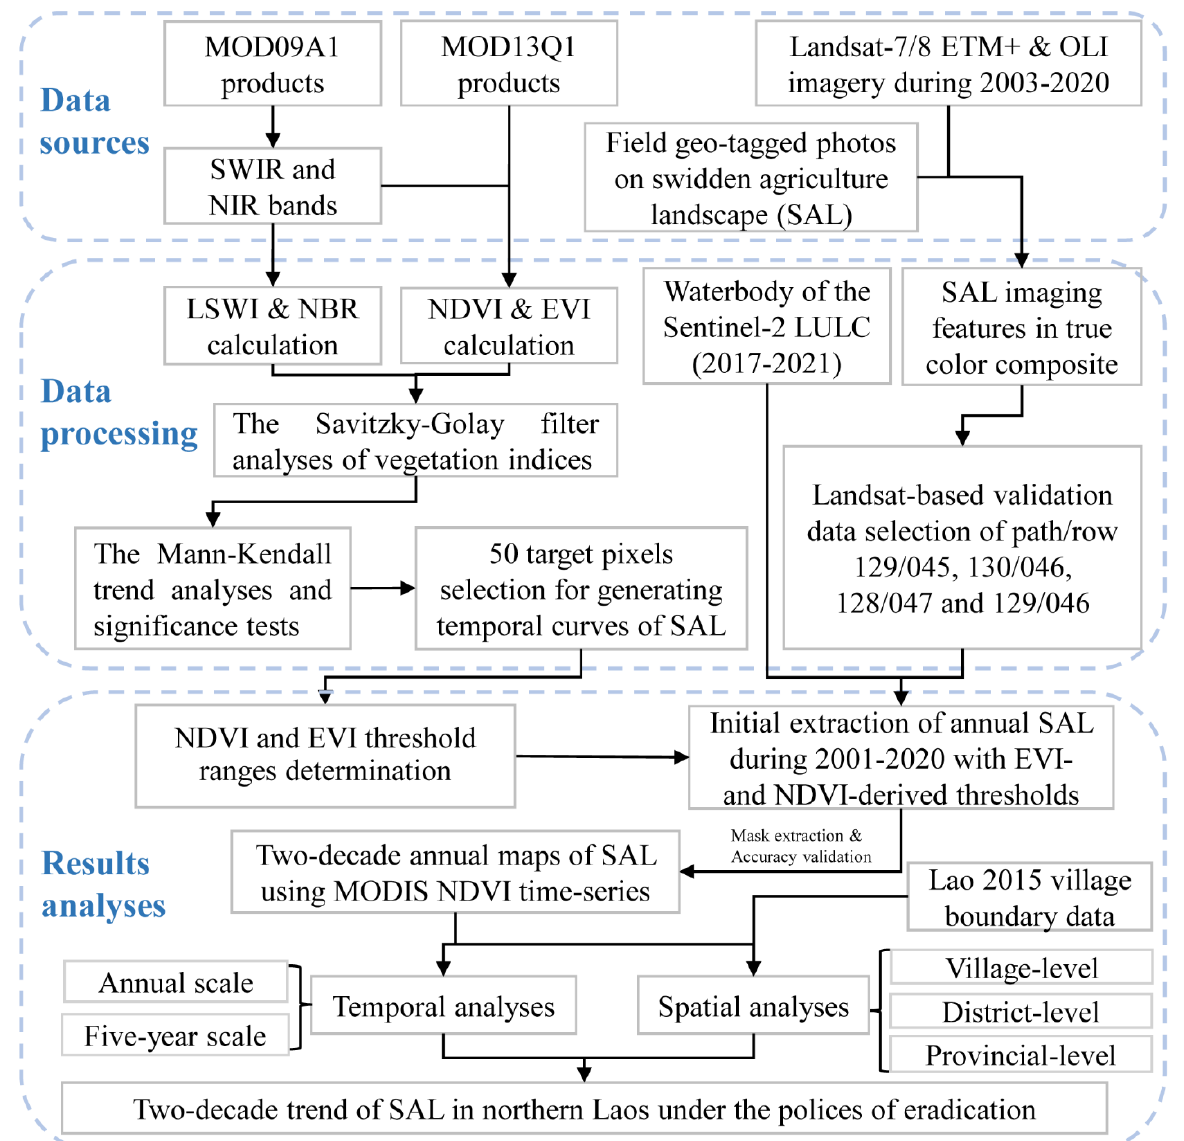
Figure 2. The workflow for mapping swidden agriculture landscape (SAL) using time-series MODIS vegetation indices in northern Laos.